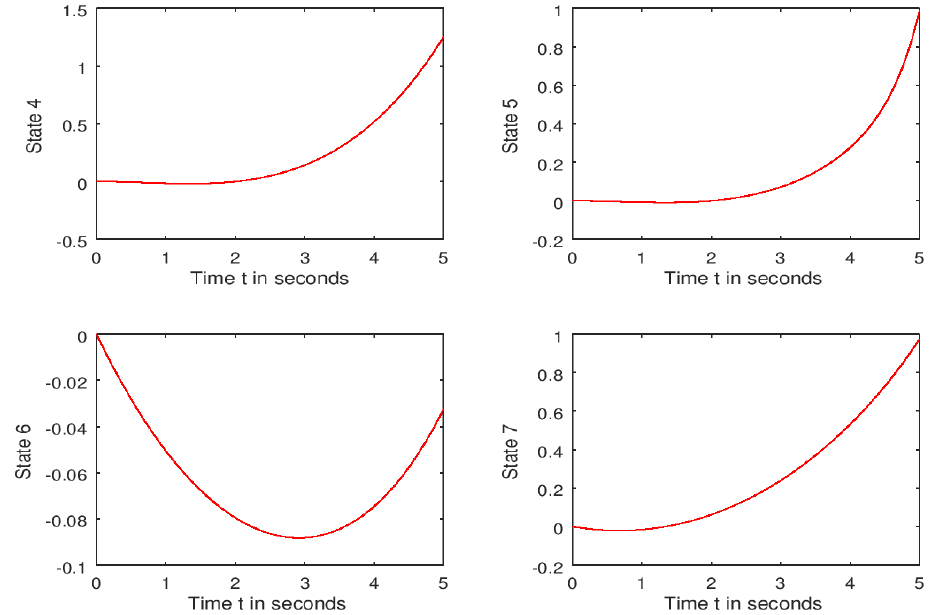
Figure 12. Feasible last four state trajectories: state 4, state 5, state 6, state